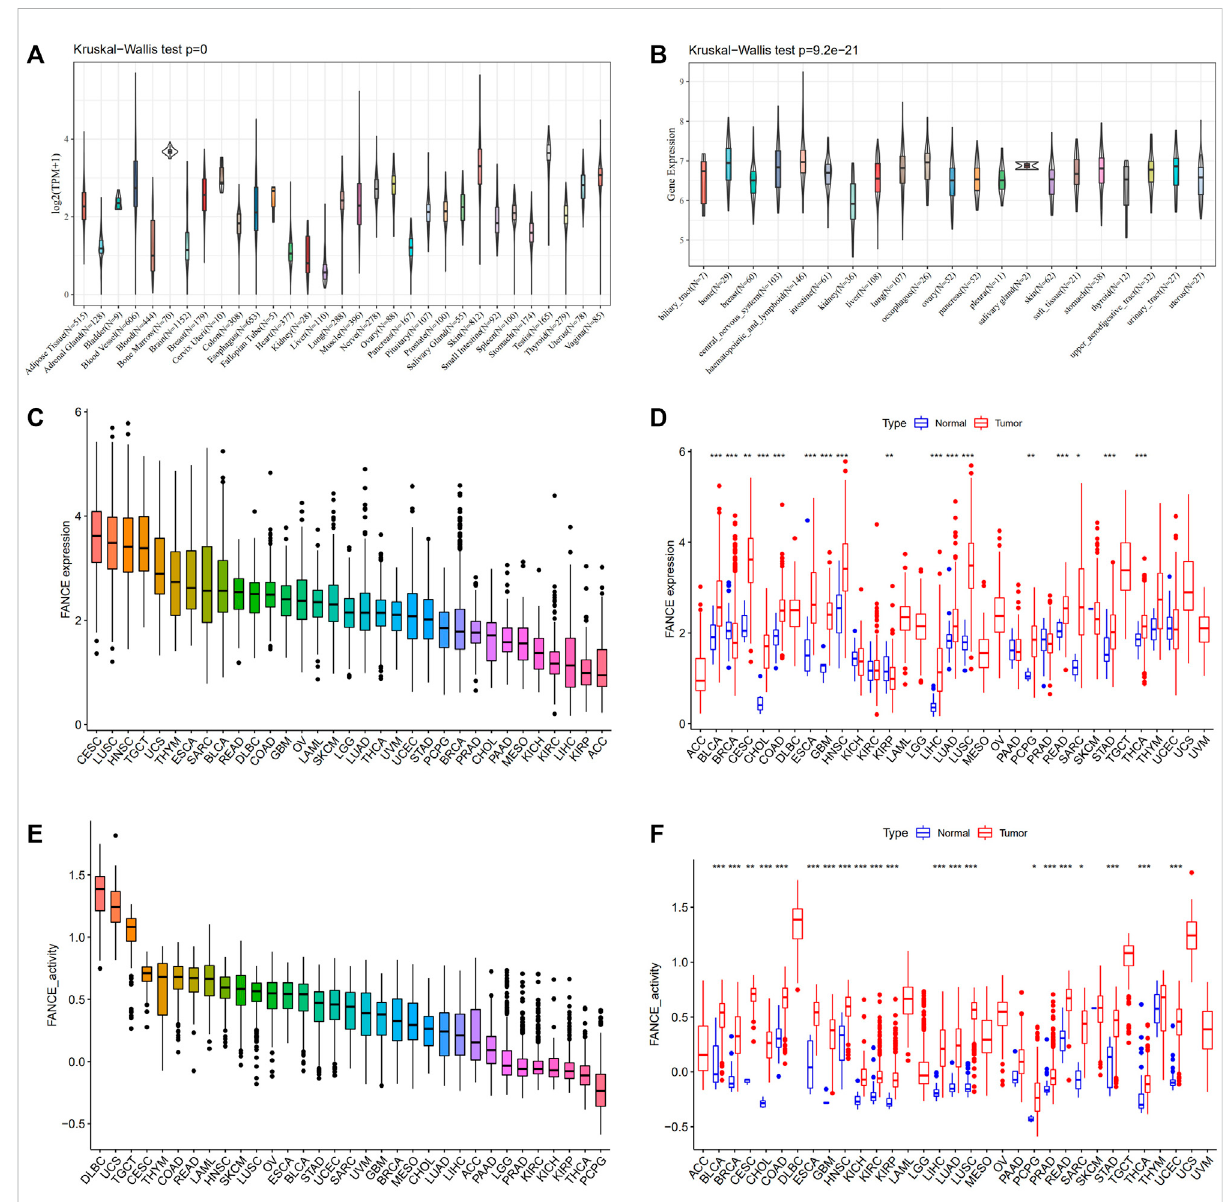
FIGURE 1 Expression and gene activity scores of FANCE . (A) FANCE expression in 31 normal tissues from the Genotype Tissue-Expression (GTEx) database. (B) FANCE expression in 21 tumor cell lines from the Cancer Cell Line Encyclopedia (CCLE) database. (C) The expression of FANCE in 33 cancers ranked from highest (left) to lowest (right) in the TCGA database. (D) The expression of FANCE in 33 cancers compared to normal tissues from The Cancer Genome Atlas (TCGA) database. (E) Gene activity scores of FANCE in 33 cancers ranked from highest (left) to lowest (right) based on TCGA and sngle-sample gene set enrichment analysis (ssGSEA). (F) Gene activity scores of FANCE in 33 cancers compared to normal tissues based on TCGA and ssGSEA. * p < .05; ** p < .01; and *** p <